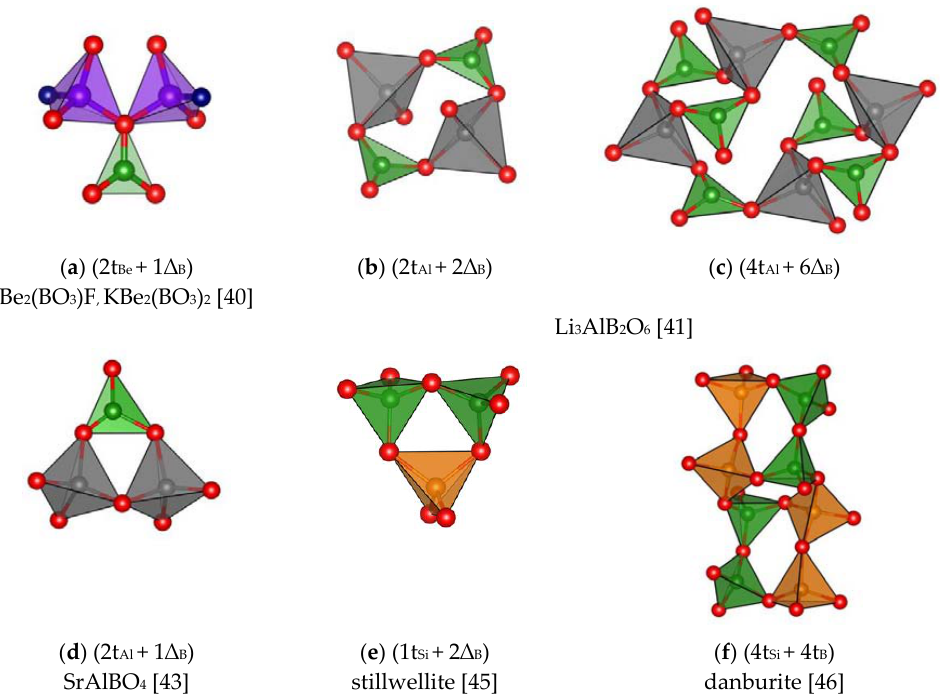
Figure 5. CSU in boroberyllates, boroaluminates and borosilicates (the green, red, violet, grey, and brown balls represent B, O, Be, Al, and Si atoms, respectively). ( a ) Be 2 (BO 3 )F , KBe 2 (BO 3 ) 2 [40]; ( b ) and ( c ) Li 3 AlB 2 O 6 [41]; ( d ) SrAlBO 4 [43]; ( e ) stillwellite [45];( f ) danburite [46].